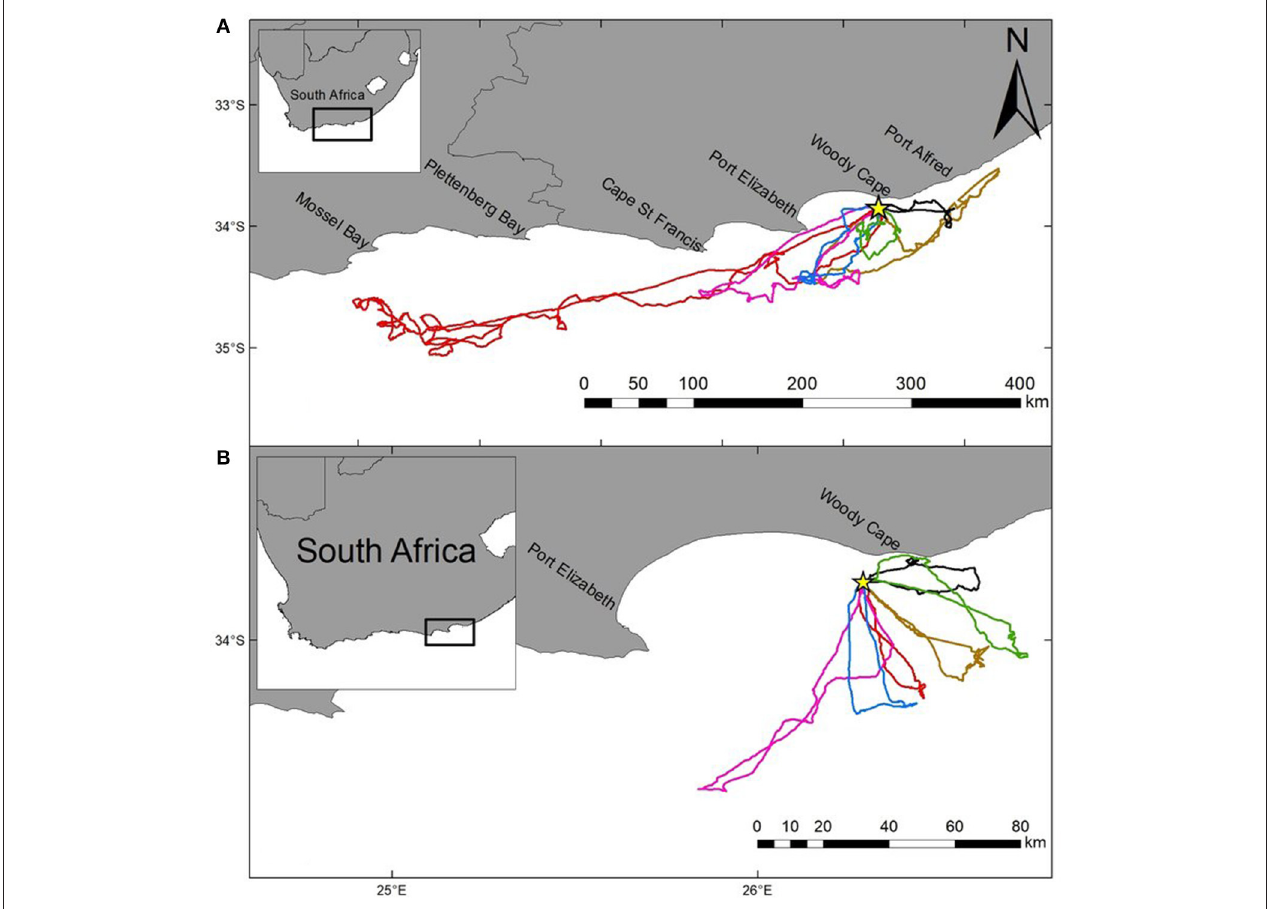
FIGURE 2 | Foraging trips (GPS tracks) for six individual Cape gannets tracked over two consecutive foraging trips during the post-guard stage of the 2015/16 breeding season. Both the longer (A) and shorter (B) trips are indicated for each individual (unique color). Bird Island is indicated by a yellow star.